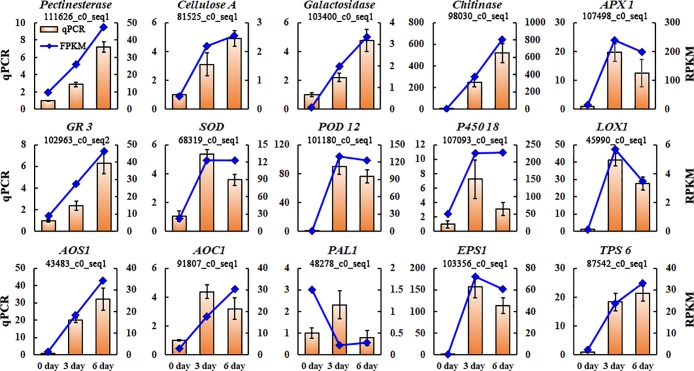
qPCR validations of 15 genes involved in plant defense response.The histograms show the qPCR results of 15 genes involved in defense response in stems of D.cambodiana after injecting the inducer in 0, 3, 6 days respectively; the line charts show the FPKM values of these unigenes. qPCR results represent the mean (±SD) of three biological replicates.